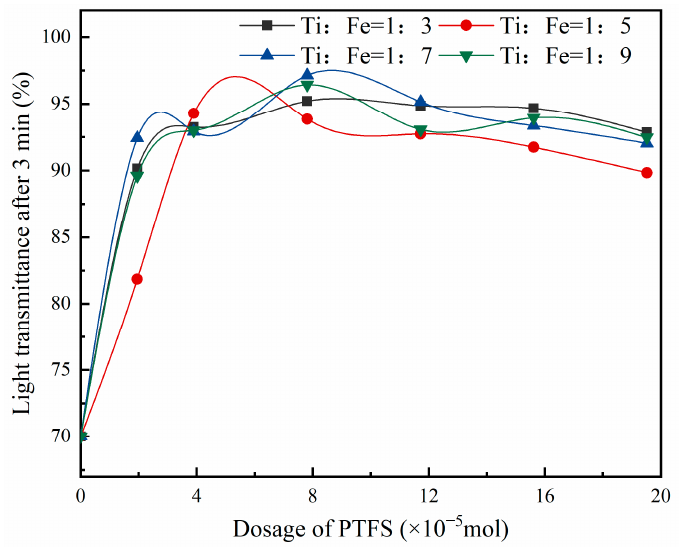
Figure 4. Comparison of the sedimentation effect of PAM and PTFS with different ratios of ferro titanium.